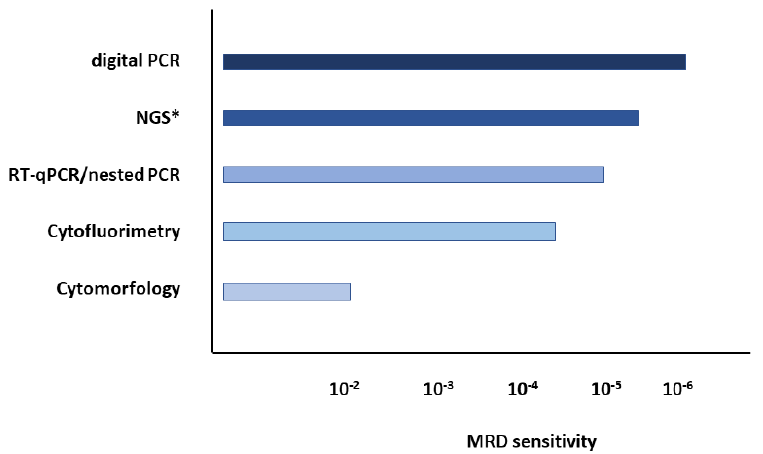
Figure 1. Graphical representation of the sensitivity of different approaches for minimal residual disease monitoring in hematological malignancies. * = the sensitivity is estimated on the detection capability. The quantification is estimated at 10 –4 . NGS = Next Generation Sequencing (gene panels resequencing); PCR = polymerase chain reaction; RT-qPCR = Real Time quantitative PCR; MRD = Minimal Residual Disease.